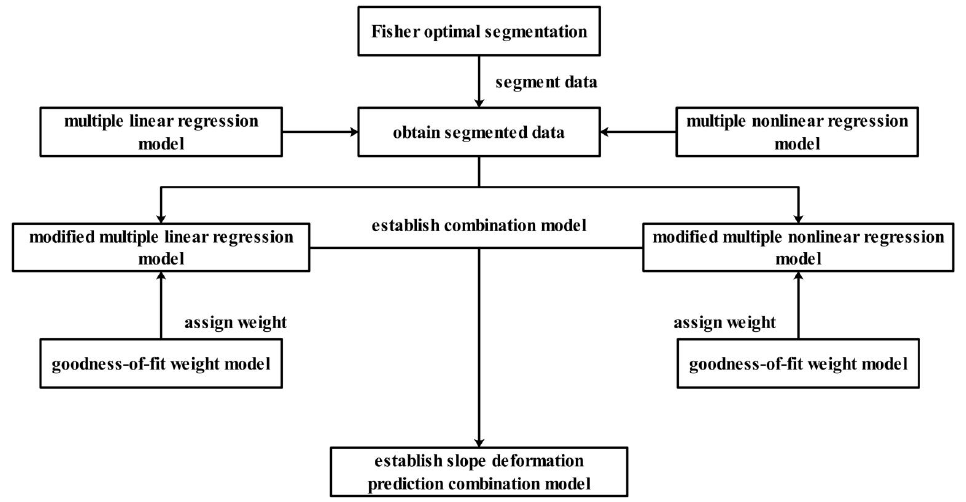
Figure 1. The technical rout of the modified slope deformation prediction combination model.